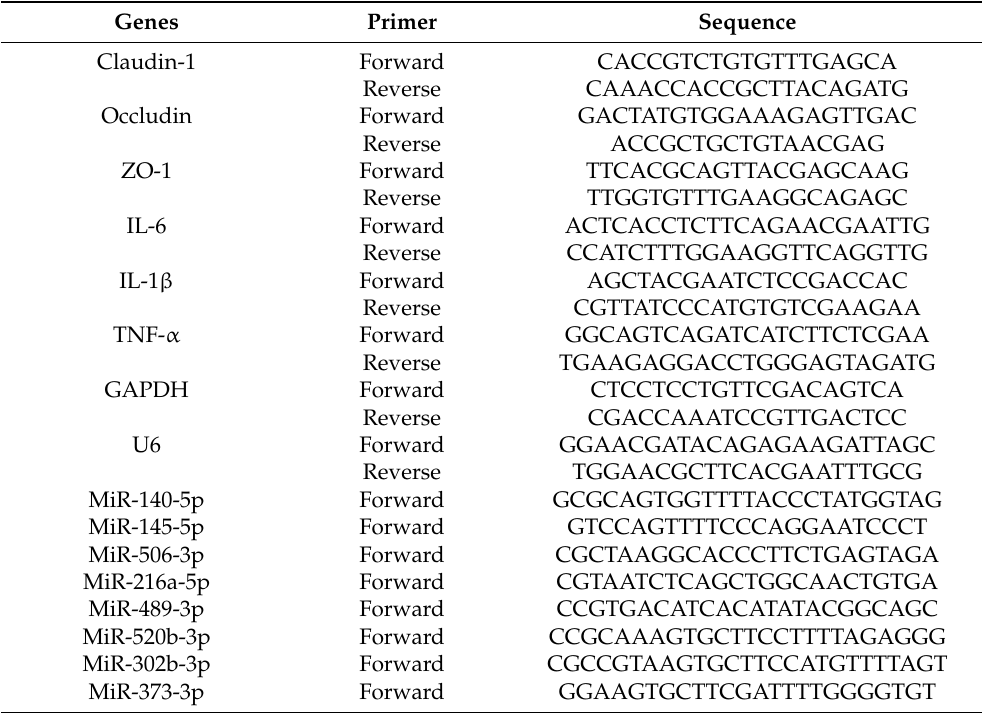
Table 1. The sequences of primers used in the qRT-PCR